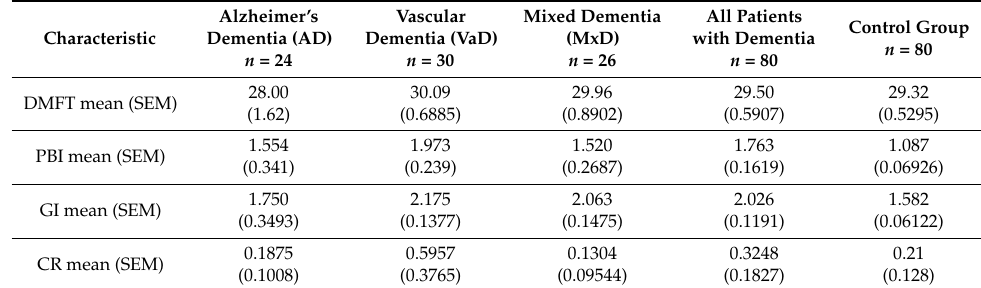
Table 2. Stomatological characteristics of the patients.